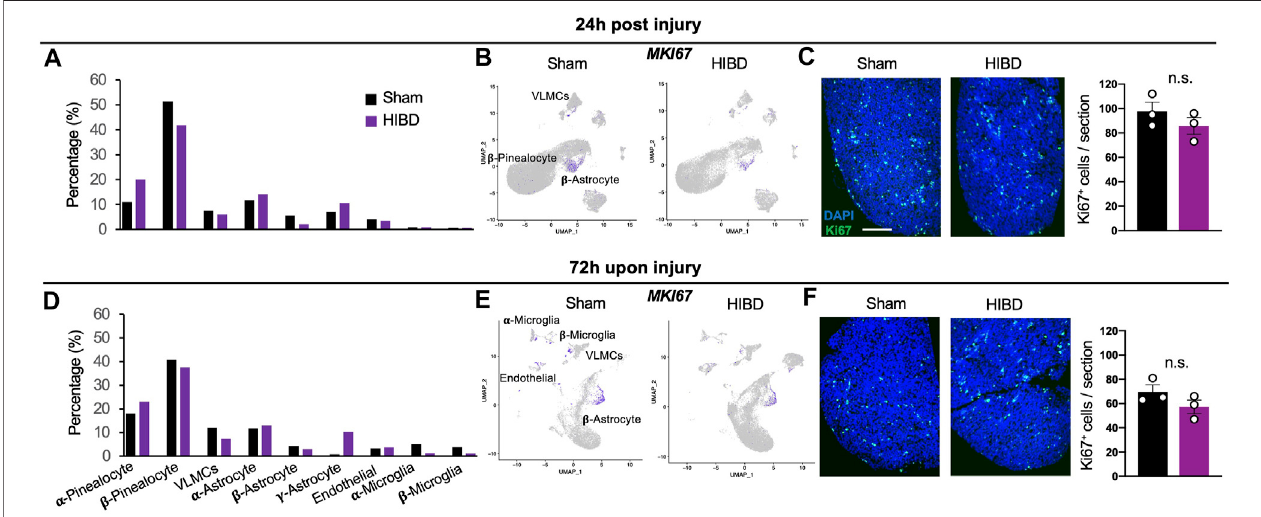
FIGURE2| Cellcompositionand proliferationofthepinealglandpostneonatalHIBD (A,D) Relativecompositionofdistinctcelltypesintotalpinealcells(%)at24 h (A) or 72 h (D) post sham or neonatal HIBD, respectively (B,E) Feature plots of Ki67 among distinct cell types of the pineal gland at 24 h (B) or 72 h (E) post sham or neonatal HIBD, respectively (C,F) Representative images of transverse sections of the pineal gland with immunostaining against Ki67 and quanti fi cation at 24 h (C) or 72 h (F) post sham or neonatal HIBD, respectively. Scale bar: 200 μ m n = 3,3 for sham and HIBD animals, fi ve sections crossing the pineal gland were used for individual animals, Student ’ s t test, n. s, no statistical signi fi cance.